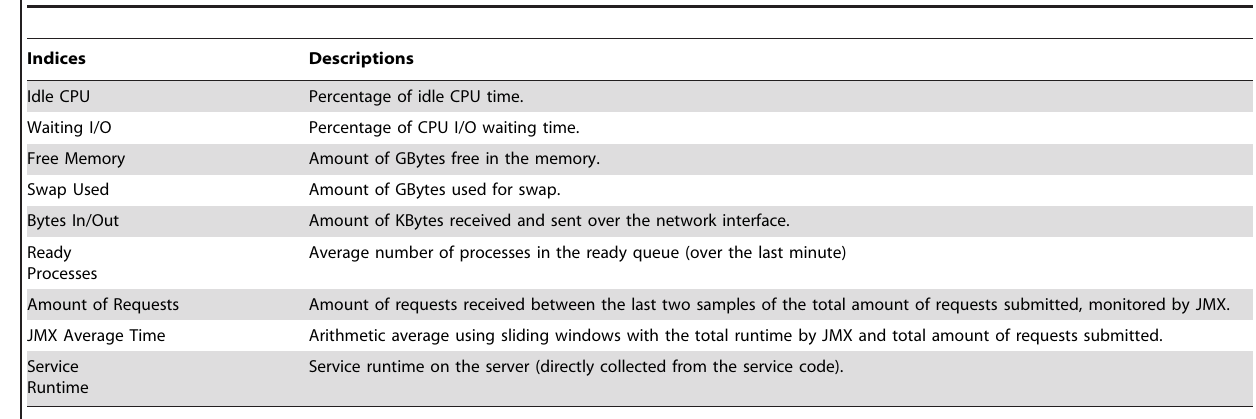
Table 1. Load indices analysed in the experiments.